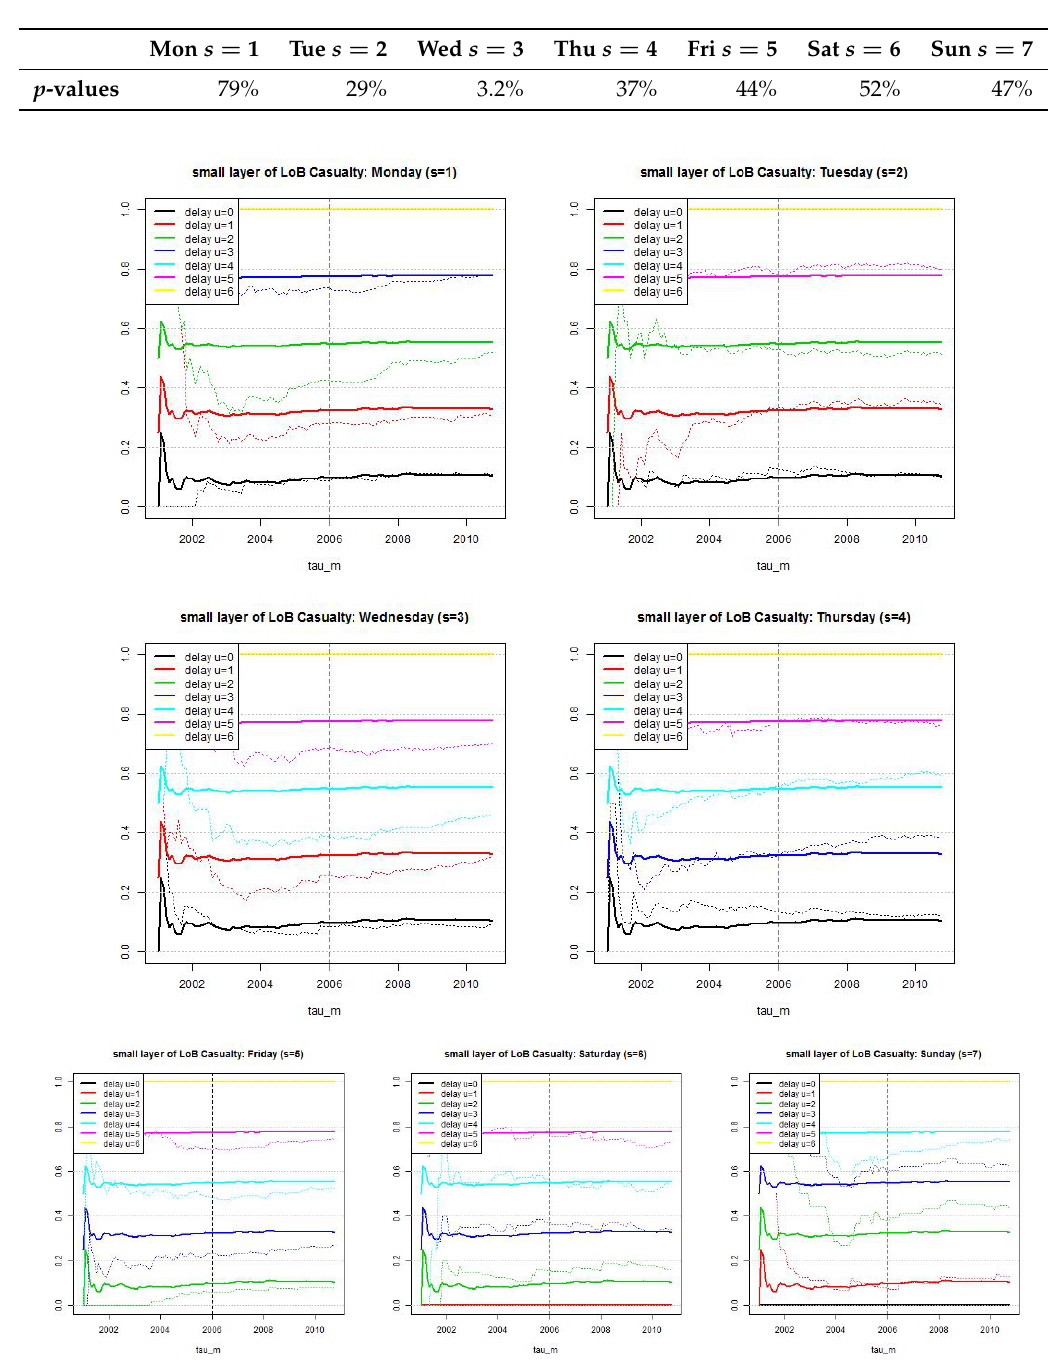
Table 4. p -values of the χ 2 -tests under the corresponding null hypotheses for test statistics χ 2 s , see Equation (22), for weekdays s = 1, . . . ,7 (with 4 degrees of freedom).